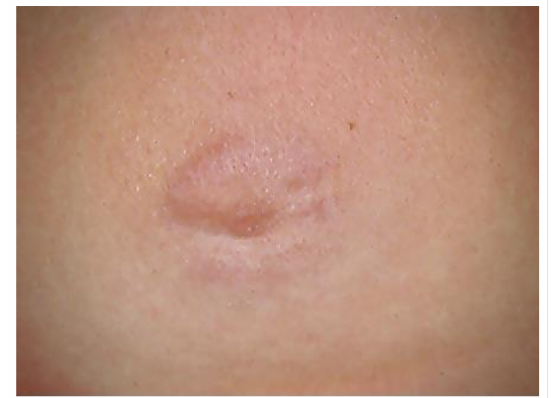
Figure 8. Borrelia lymphocytoma of the breast (photo by G.